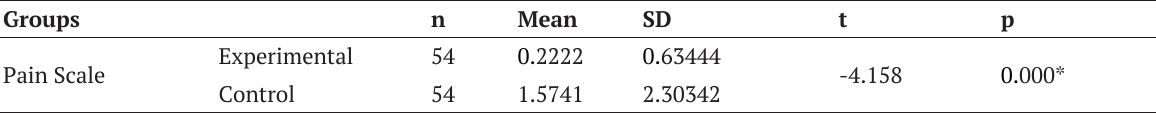
Table 9. Pain scale analysis of the study group (Experimental-Control) Groups